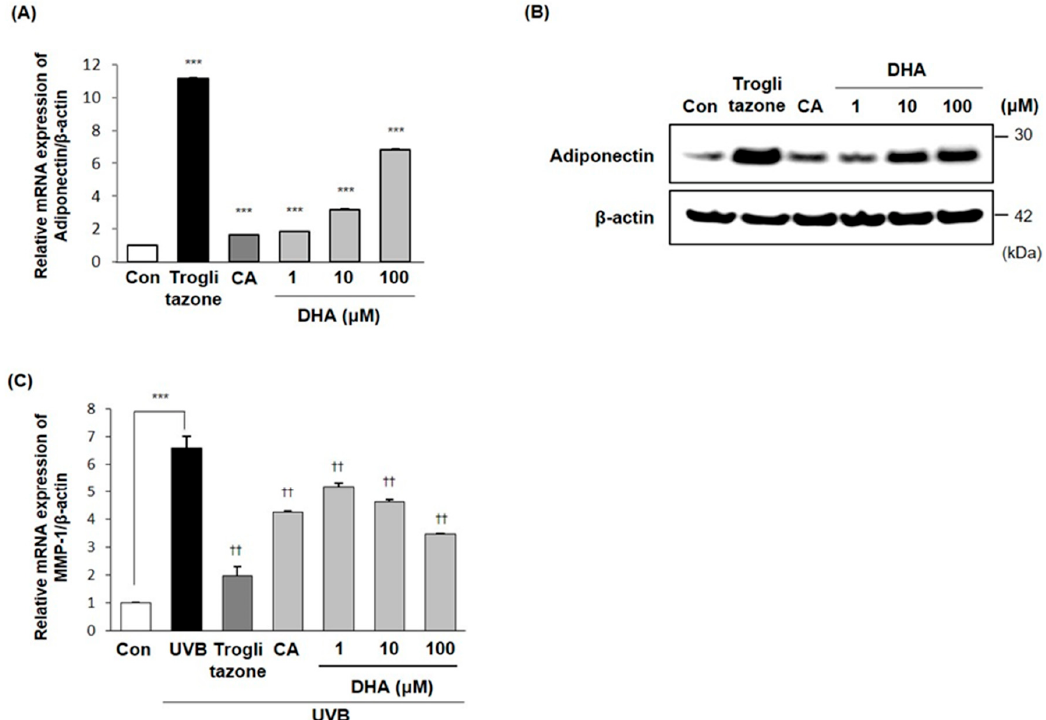
Figure 4. DHA inhibited MMP-1 mRNA expression via an increase in adiponectin production from adipocytes. The 3T3-L1 cells were induced to di ff erentiate with or without treatment of DHA for 6 days, and the adiponectin ( A ) mRNA and ( B ) protein expression levels were measured by RT-qPCR and immunoblotting. The resulting conditioned medium was applied to UVB-irradiated Hs68 fibroblasts for 24 h. ( C ) MMP-1 mRNA was then measured by RT-qPCR. The means ± SEs are the average of three independent experiments. *** p < 0.001 compared to the control, †† p < 0.01 compared to the UVB-irradiated control.